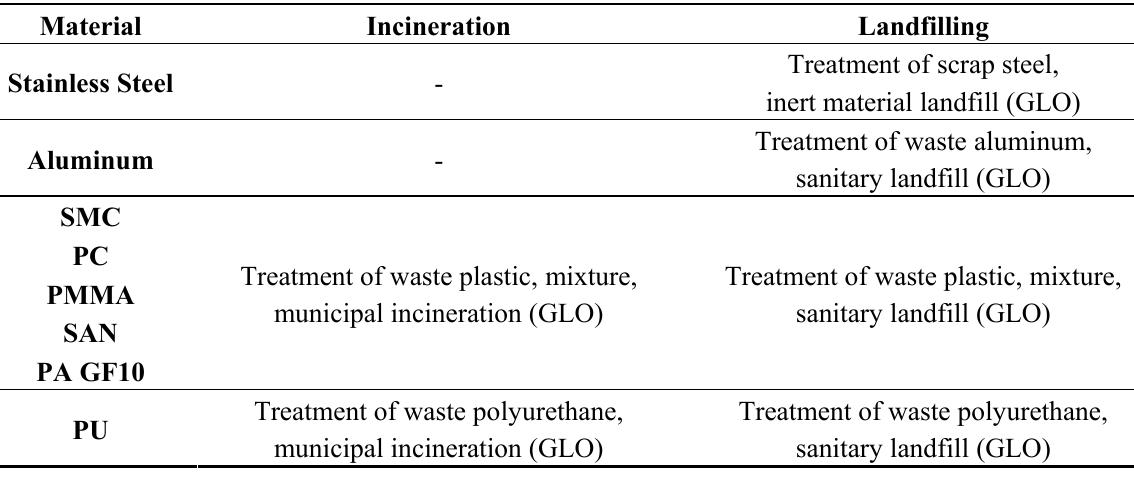
Table 4. End of life